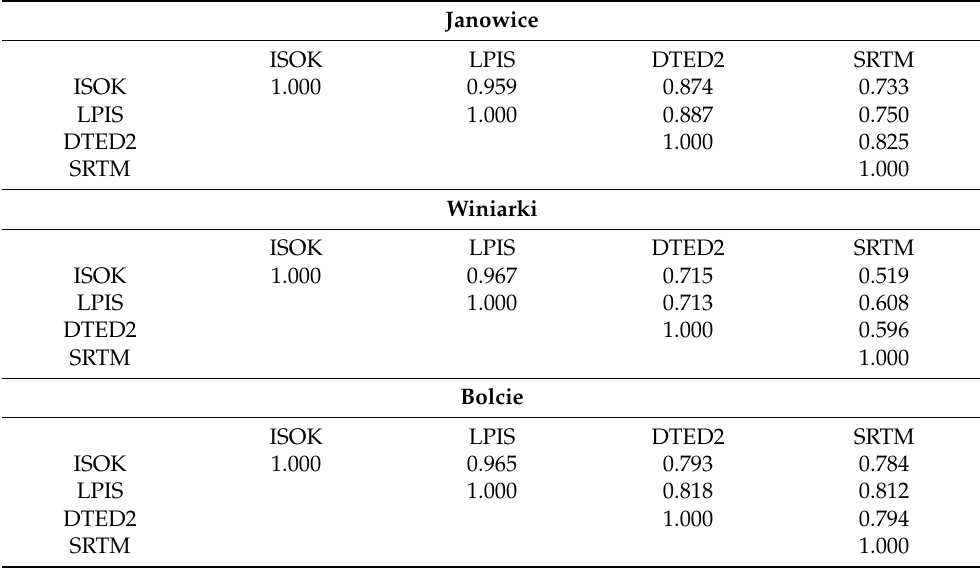
Table 14. The summary of the Pearson correlation coefficient values for the sum of the total LS values calculated on the basis of the 4 DTM sources for the agricultural plots in the 3 research areas.